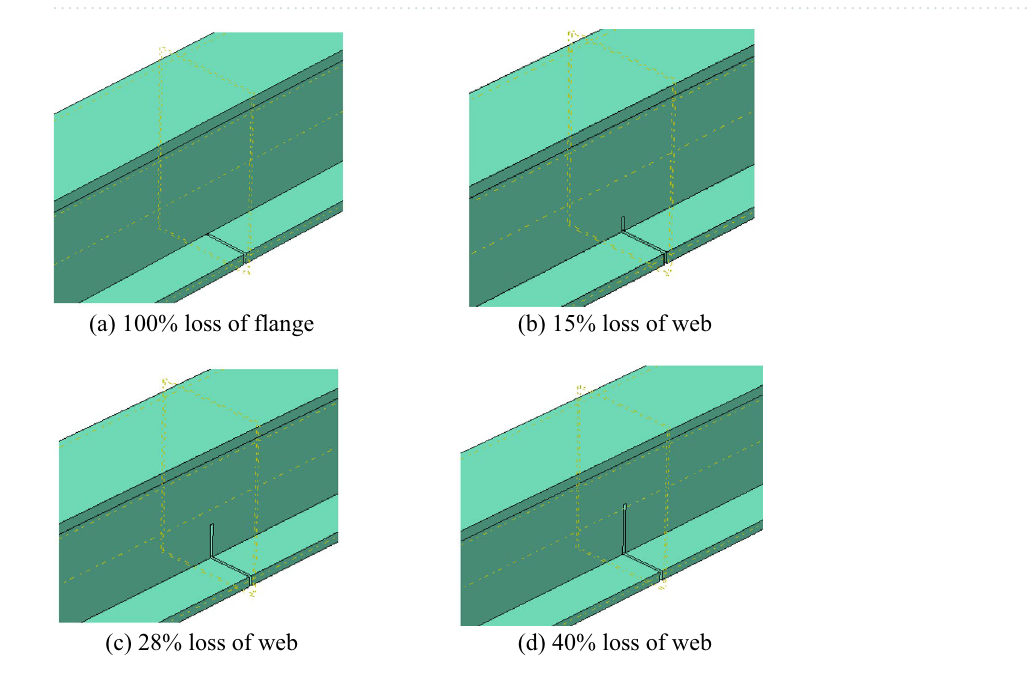
Figure 10. Damage model.